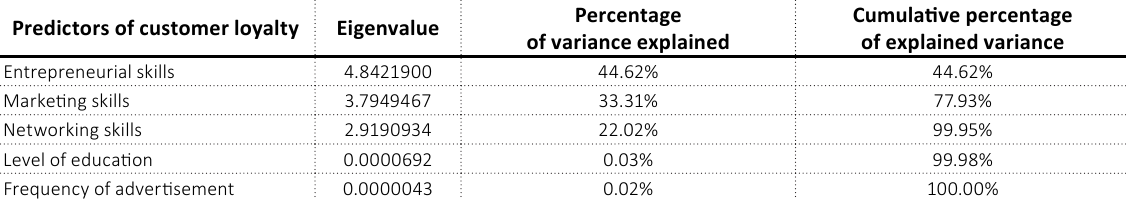
Table 7. Estimated eigenvalues of predictors of customer loyalty ( n =